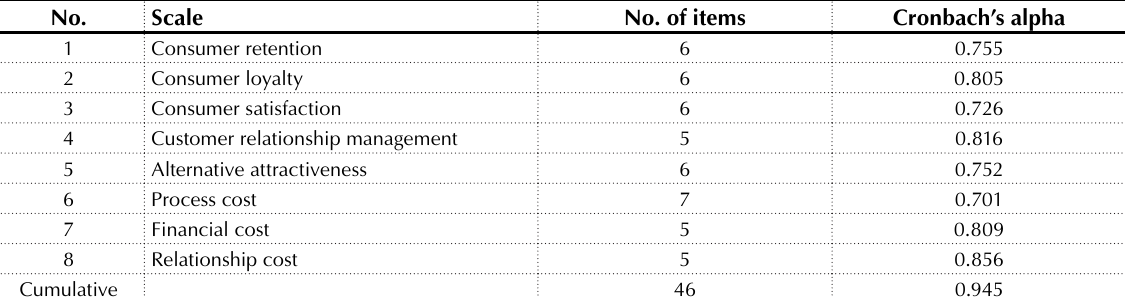
Table 1. Reliability analysis